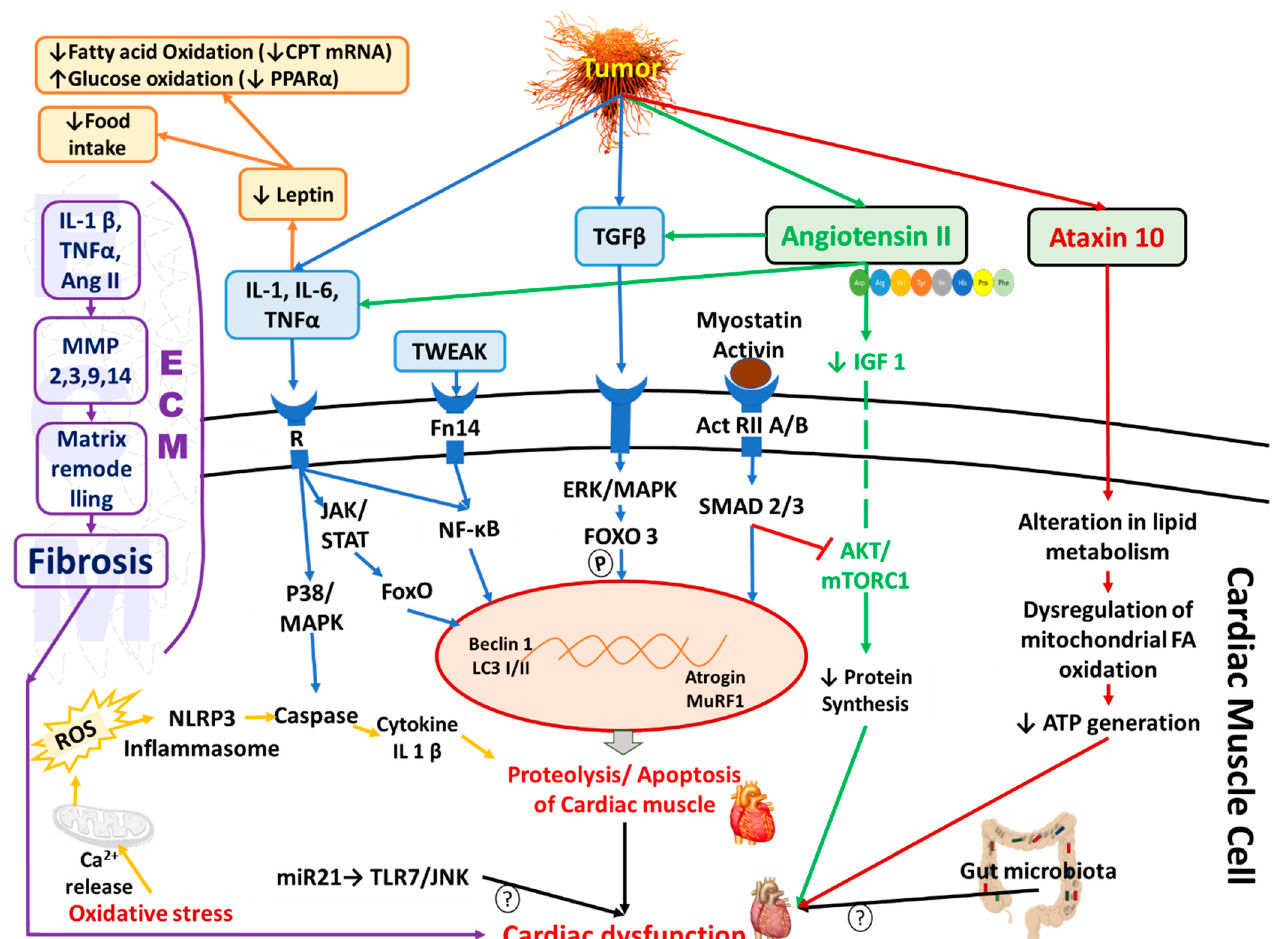
Figure 2. Schematic diagram showing the molecular mechanisms underlying cardiac cachexia in cancer patients. Some pathways, such as the cytokine, myostatin, activin, and leptin-mediated signalling pathways, are involved in both skeletal and cardiac muscle wasting. IL: interleukin, ROS: reactive oxygen species, NFkB: nuclear factor kappa B, IGF1: insulin-like growth factor 1, TNF: tumor necrosis factor, TGF: transforming growth factor, ERK: extracellular signal-regulated kinases, ActRIIA: activin type II receptors A, Foxo: forkhead transcription factors, MuRF 1: muscle ring finger protein-1, LC3: microtubule-associated protein 1A/1B-light chain 3, mTOR: mammalian target of rapamycin, NLRP3: NLR family pyrin domain containing 3, TLR: Toll-like receptor, miRNA: micro RNA, JNK: c-Jun N-terminal kinase, ECM: extra-cellular matrix. “ ↑ ” denotes increase. “ ↓ ” denotes decrease. Redrawn with modification from reference [27] .